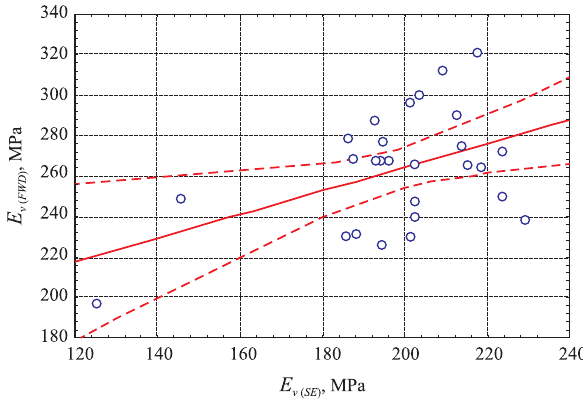
Fig. 4. Relationship between the measuring results of the FWD Dynatest 8000 and the static beam Strassentest on a base course (left